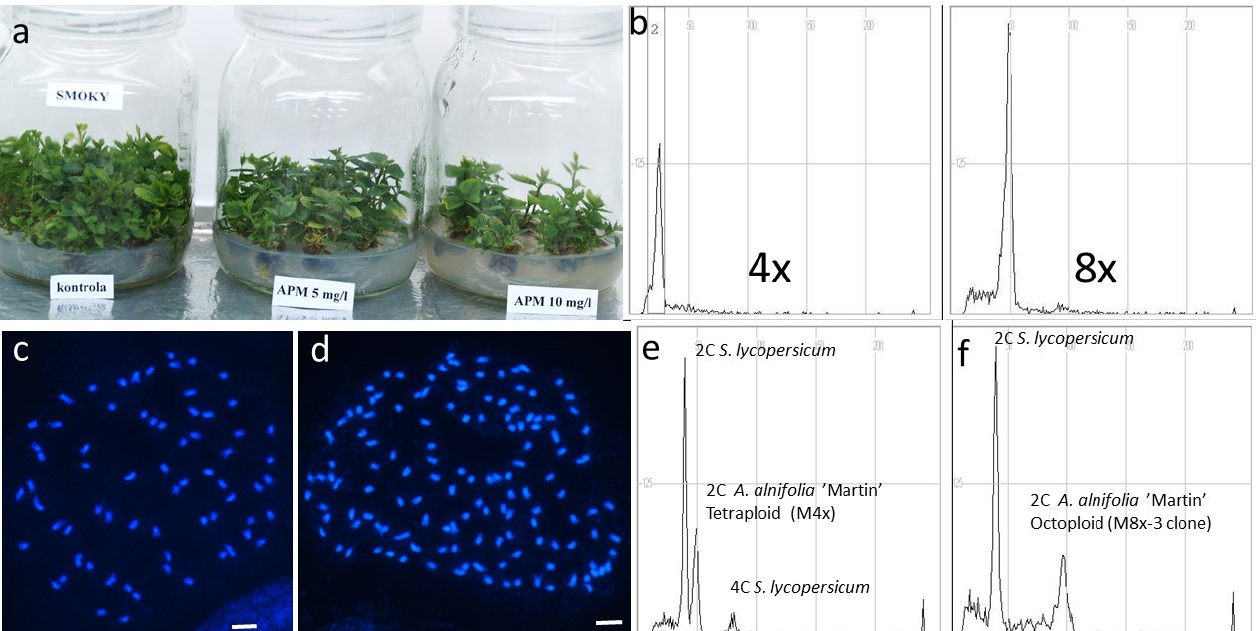
Figure 1. Induction and detection of octoploids. ( a ) In vitro shoot cultures of Saskatoon berry cv. ‘Smoky’ in the control medium and with the addition of 5 and 10 mg L −1 APM. ( b ) Histograms of cytometric analysis FCM-DAPI; the position of the peak of nuclear DNA fluorescence on the X axis for tetraploid (left) and octoploid (right); on the Y axis, the number of nuclei with a specified level of fluorescence. ( c ) Metaphase chromosomes of tetraploid cv. ‘Martin’ (2n = 4x = 68). ( d ) Metaphase chromosomes of octoploid ‘Martin’ (2n = 8x = 136). Histograms of nuclear DNA estimation using flow cytometry (FCM-PI) with internal standard: Solanum lycopersicum (2C DNA = 1.96 pg) for the genotypes: ( e ) ‘Martin’ control 4x (2C DNA = 2.29 pg), ( f ) ‘Martin’ M 8x-3 (2C DNA = 4.57 pg).